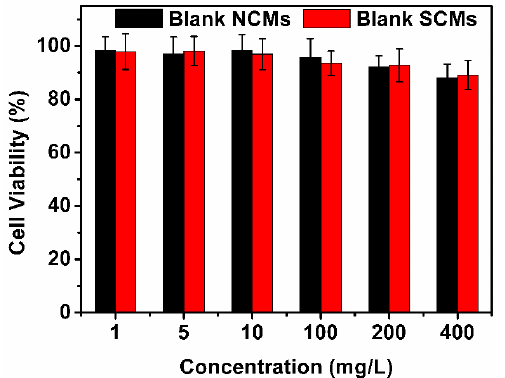
Figure 11. The in vitro cytotoxicity of blank micelles against HepG2 cells for 48 h.